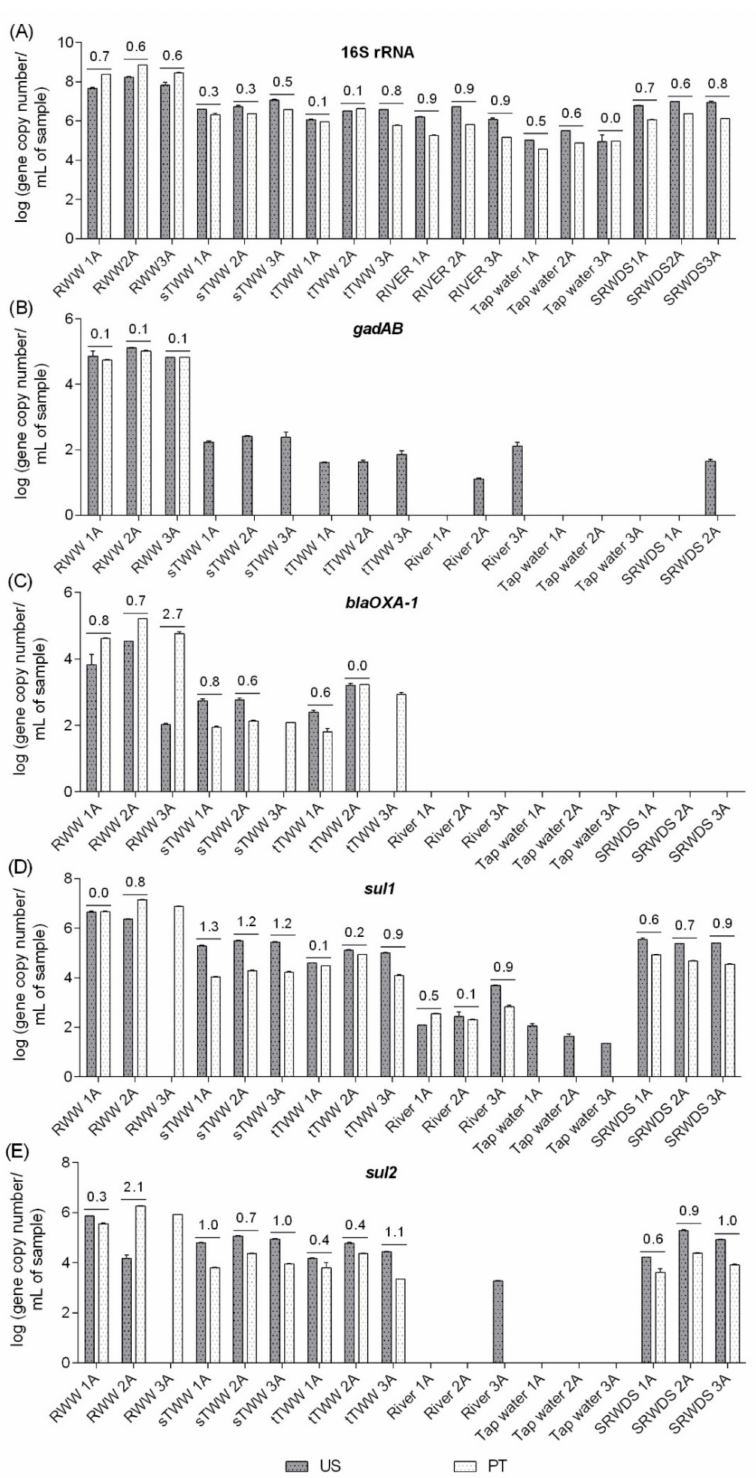
Figure 3. Inter-laboratory comparison of absolute abundance (gene copy number / mL of sample) measurements of the target genes in the six water types. RWW: wastewater treatment plant influent, sTWW: wastewater collected after secondary wastewater treatment, tTWW: wastewater collected after UV disinfection wastewater treatment;, river water, tap water, and SRWDS: simulated reclaimed water distribution system. PT refers to genes quantification performed in Portugal, the other data presented refer to genes quantification performed in the US. The lack of gene quantification (LOQ) performed